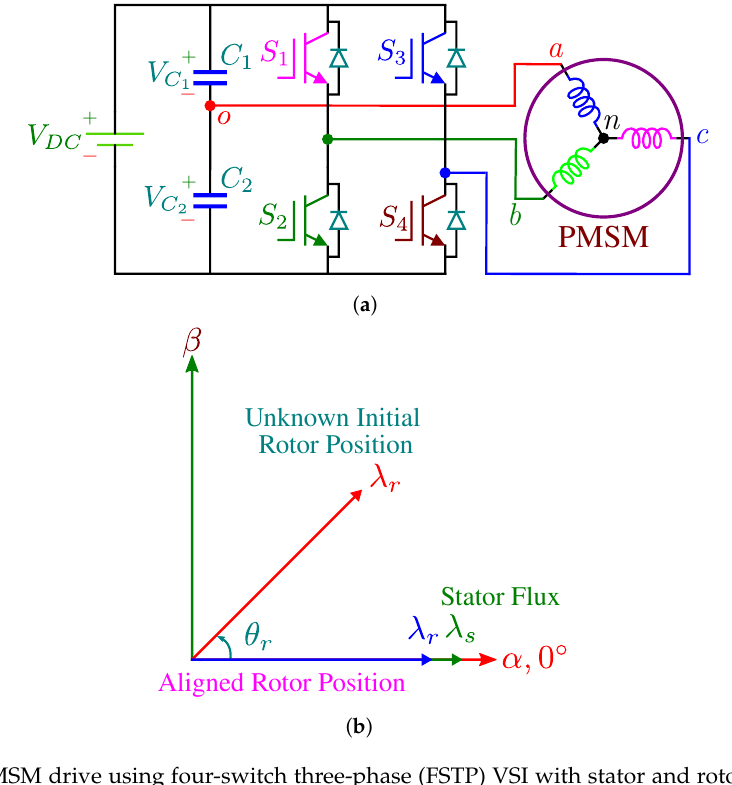
Figure 1. PMSM drive using four-switch three-phase (FSTP) VSI with stator and rotor flux linkage vectors: ( a ) Phase –a is wired to the middle of the two DC-link capacitors; ( b ) rotor alignment process.